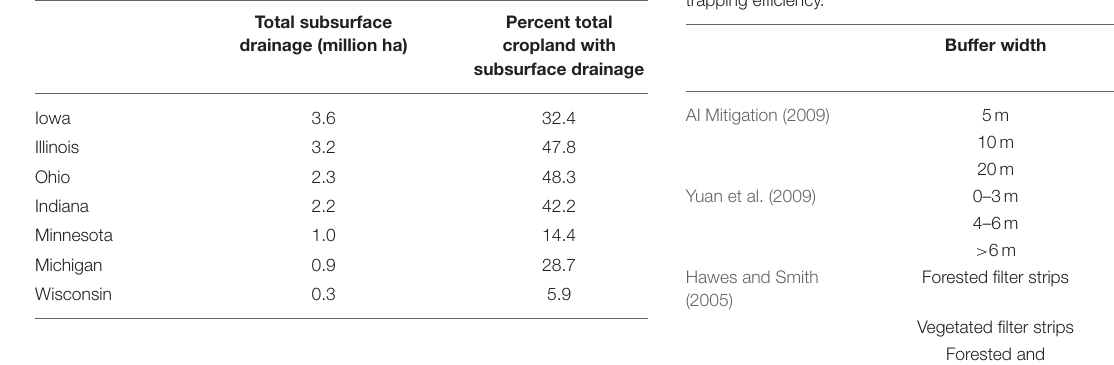
TABLE 2 | Drainage tile percentages by state (Sugg, 2007). TABLE 3 | Buffer characteristics from multiple studies on width, composition, and